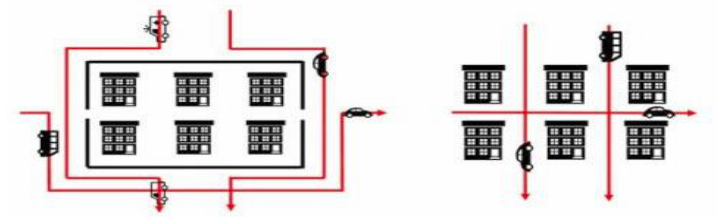
Fig. 1. The influence of block walls on the public transport (Tencent,